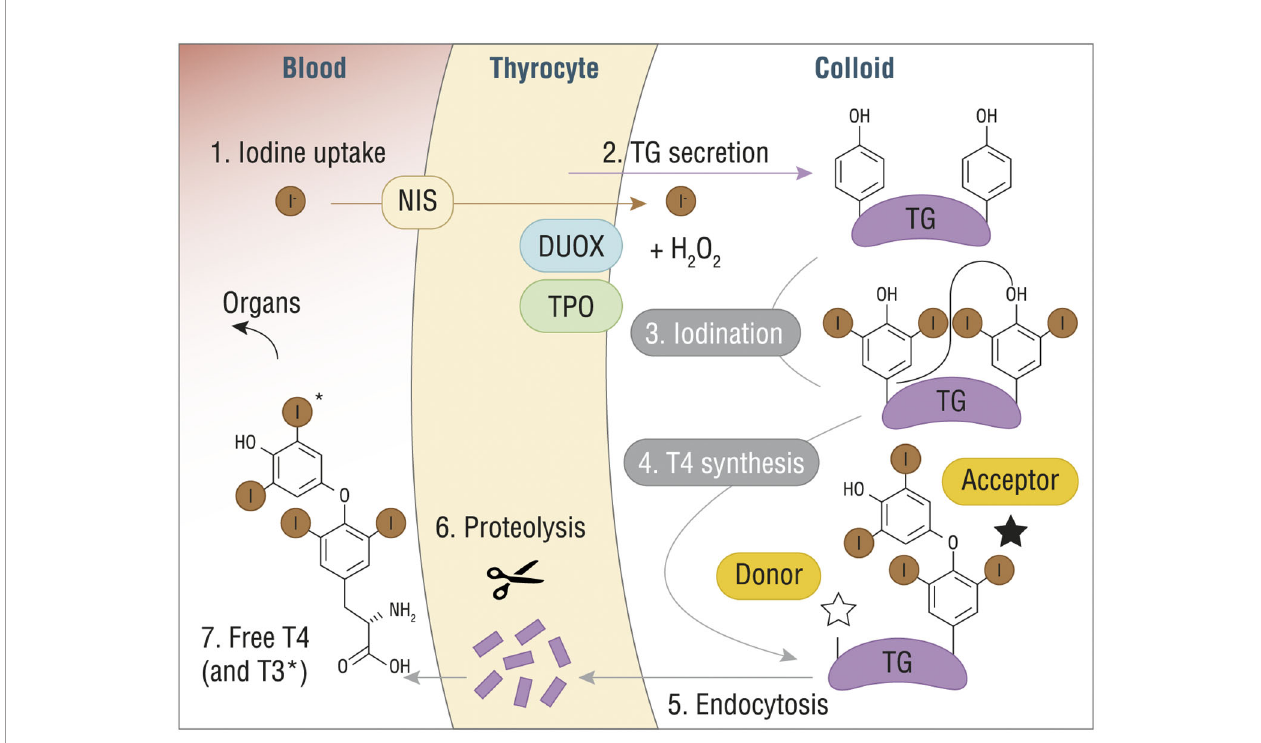
FIGURE 1 | T4 (or T3) synthesis from Tg in thyroid gland. DUOX, dual oxidase; H 2 O 2 , hydrogen peroxide; I - , iodine; NIS, sodium/iodide symporter; T3, triiodothyronine; T4, thyroxine; TG, thyroglobulin. Reproduced with the permission from “ The structure of human thyroglobulin. ” Coscia F. et al., Nature